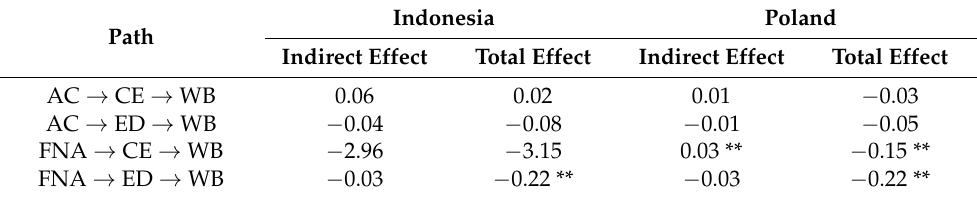
Figure 1. The structural equation model (SEM). Values represent the significant standardized regression coefficients. The values for Poland are in parentheses. ** p < 0.01; for more details on p values, see Appendix A.